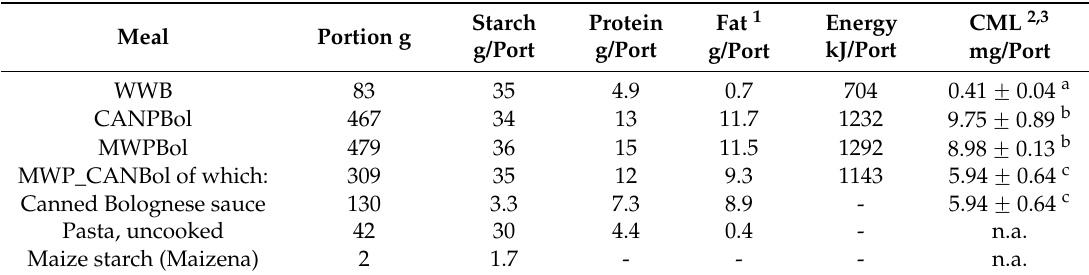
Table 2. Portion sizes and contents of macronutrients, energy, and CML in the test meals and reference meal in Study